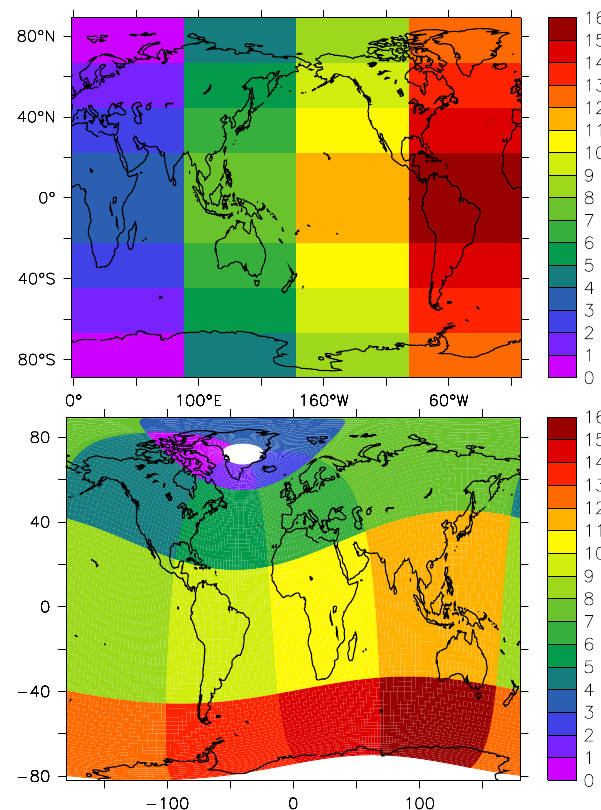
Fig. 2. Parallel (horizontal) “4 times 4” domain decomposition for a model setup with 16 tasks for the atmosphere model (upper panel) and the ocean model (lower panel). The color code denotes the task